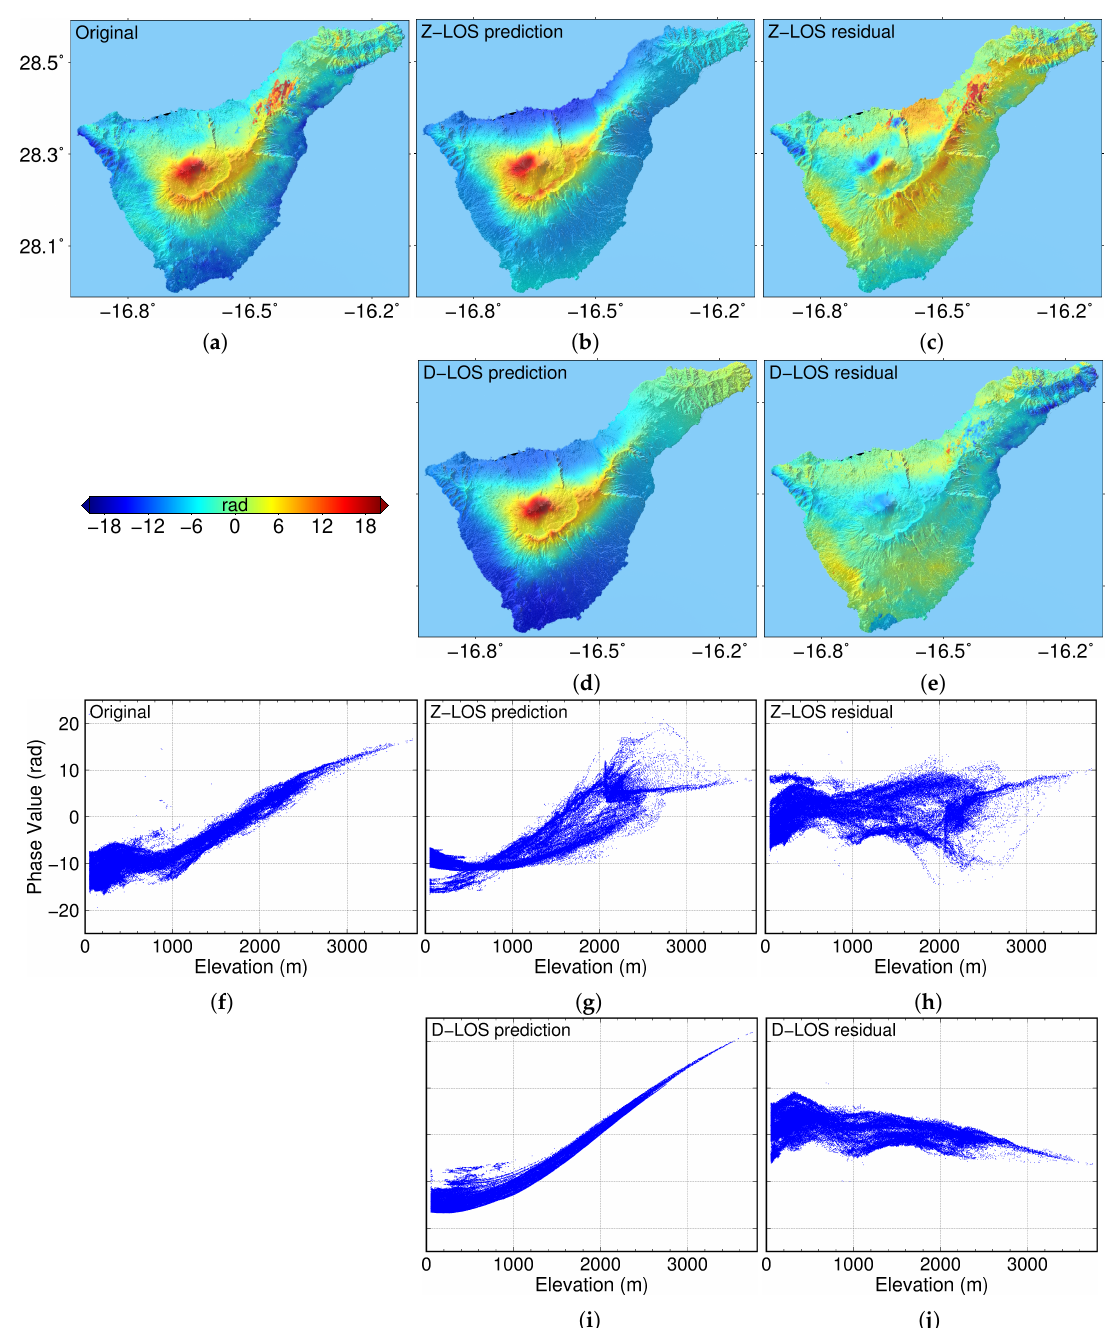
Figure 9. 20160721–20160814 (Ifg11) case study of APS compensation in Tenerife. ( a – e ) represent the original interferogram, Z-LOS predicted APS, residue phase after Z-LOS correction, D-LOS predicted APS, and the residue phase after D-LOS correction, respectively. ( f – j ) are the phase-elevation scatters for the original phase, Z-LOS predicted APS, residue phase after Z-LOS correction, D-LOS predicted APS, and the residue phase after D-LOS correction,